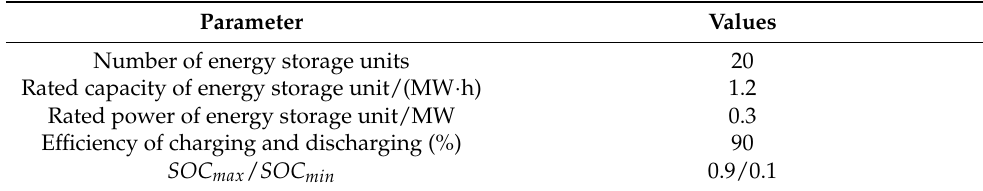
Table 1. Battery energy storage power station